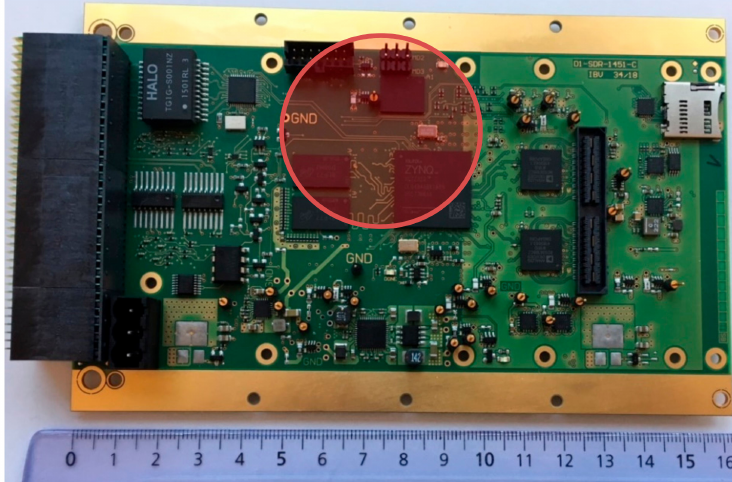
Figure 9. GSDR motherboard with highlighted radiation exposed area using a 50-mm circular collimator (covering Zynq-7020, DDR3-SDRAM and NAND